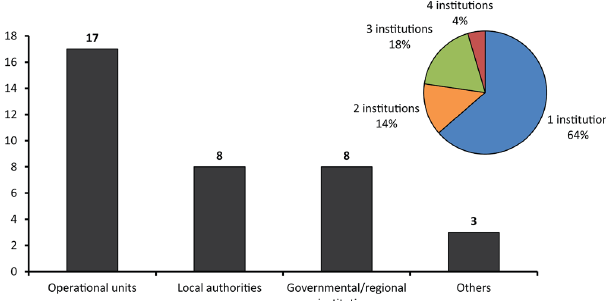
Fig. 13. Inventory of institutions involved in the establishment of strategies in case of alerts and percentage of number of institutions involved together for the 23 reported EWSs. The total number is above 22, because 36% of the strategies have been designed by more than one institute.